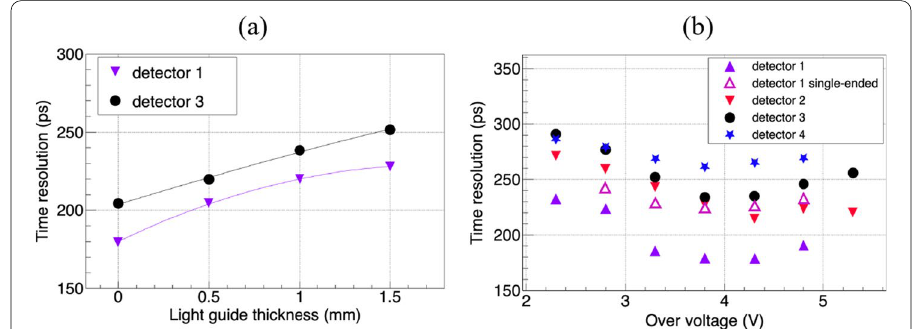
Fig. 12 a CTRs of the detectors 1 and 3 as a function of light guide thickness, b CTRs of the five detectors as a function of the SiPM over